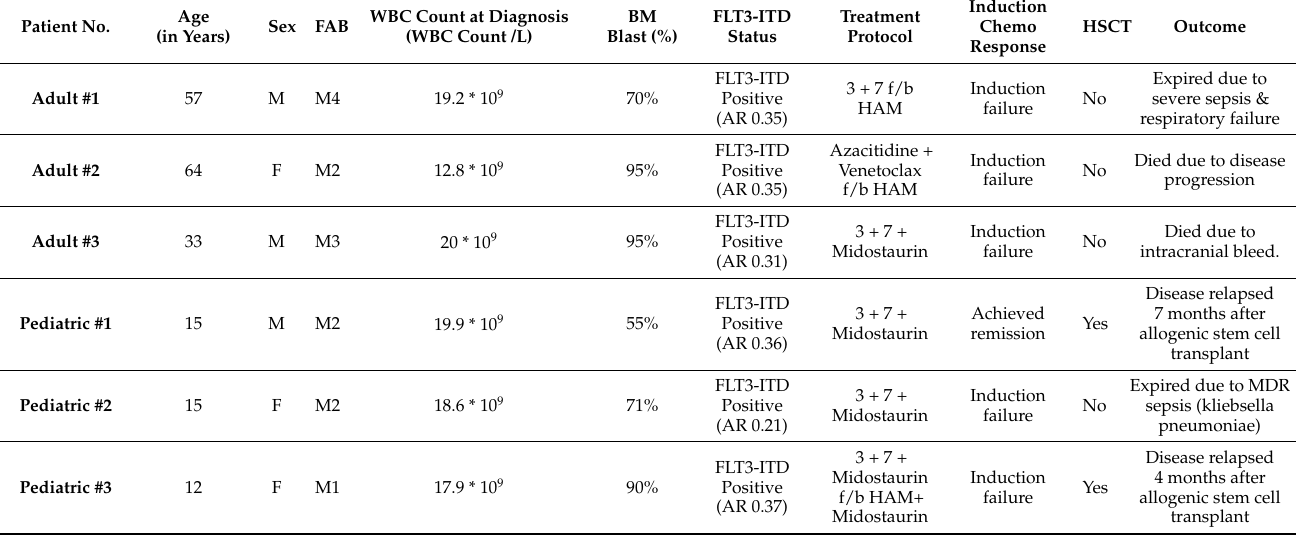
Table 2. Individual characteristics and clinical outcome of AML patients with NUP98::NSD1 fu- sion